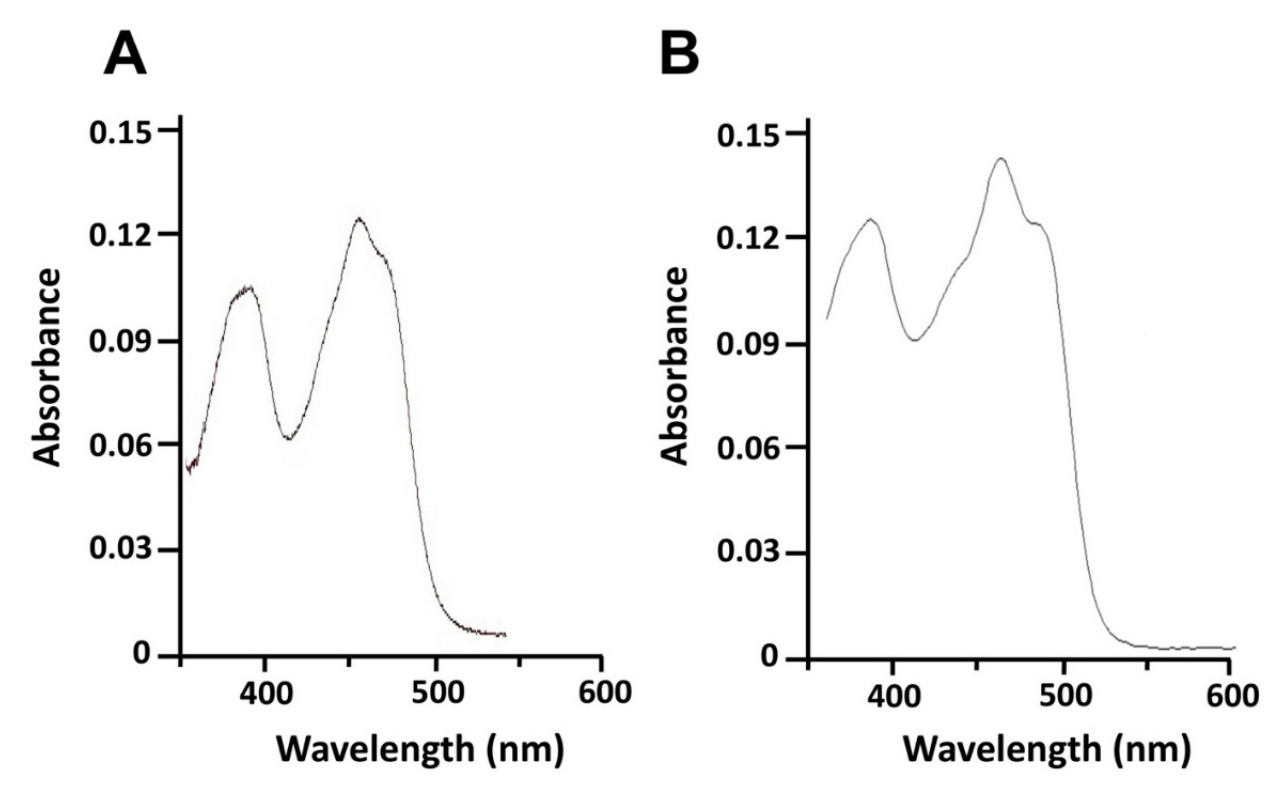
Figure 4. UV-visible absorbance spectra of purified E. coli and 0305 φ 8-36 phage flavodoxins. ( A ) Oxidized spectrum obtained for purified E. coli flavodoxin (15 μ M). ( B ) Oxidized spectrum obtained for purified phage 0305 φ 8-36 flavodoxin (15 μ M).